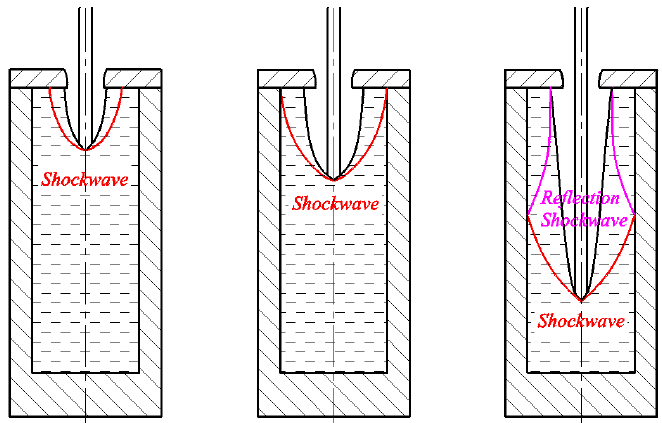
Figure 2. Schematic of the shock wave side-wall reflection in liquid.